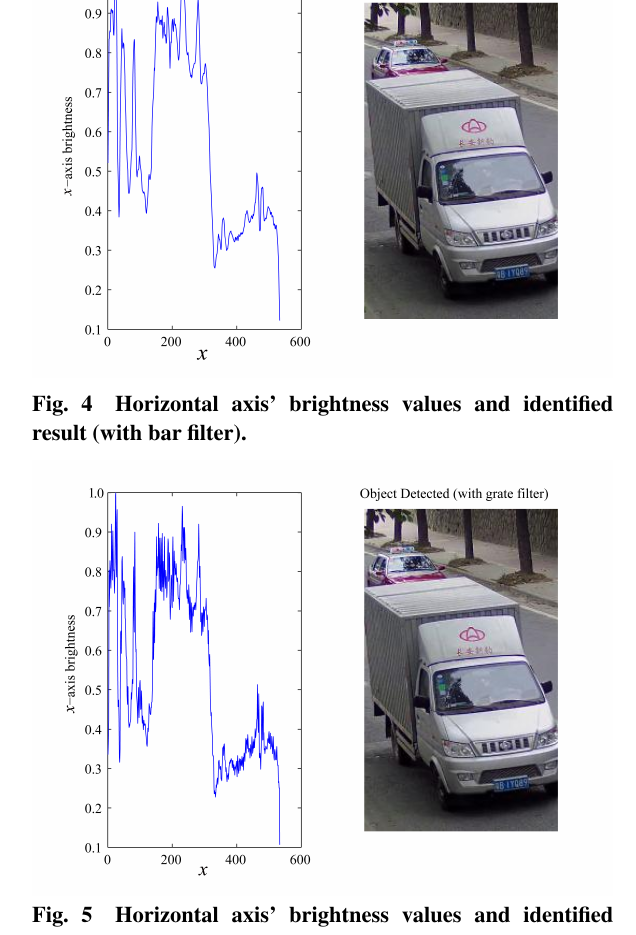
Fig. 3 Bar filter (left) and our proposed grate filter (right).